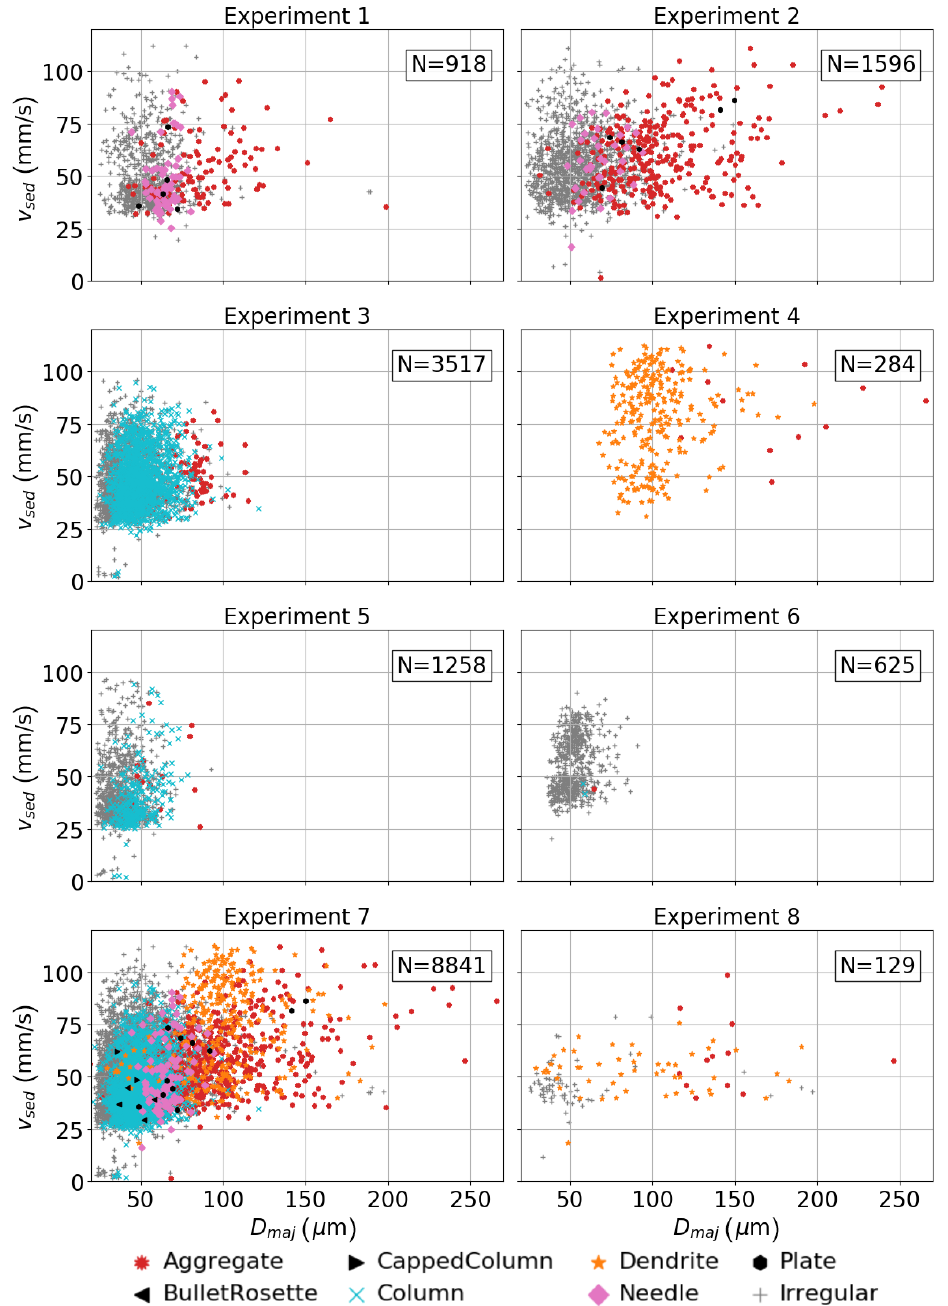
Figure 6. Sedimentation velocity ( v sed , in mms − 1 ) and size ( D maj in µm) measurements from holography particle tracking experiments (particle numbers in each experiment are